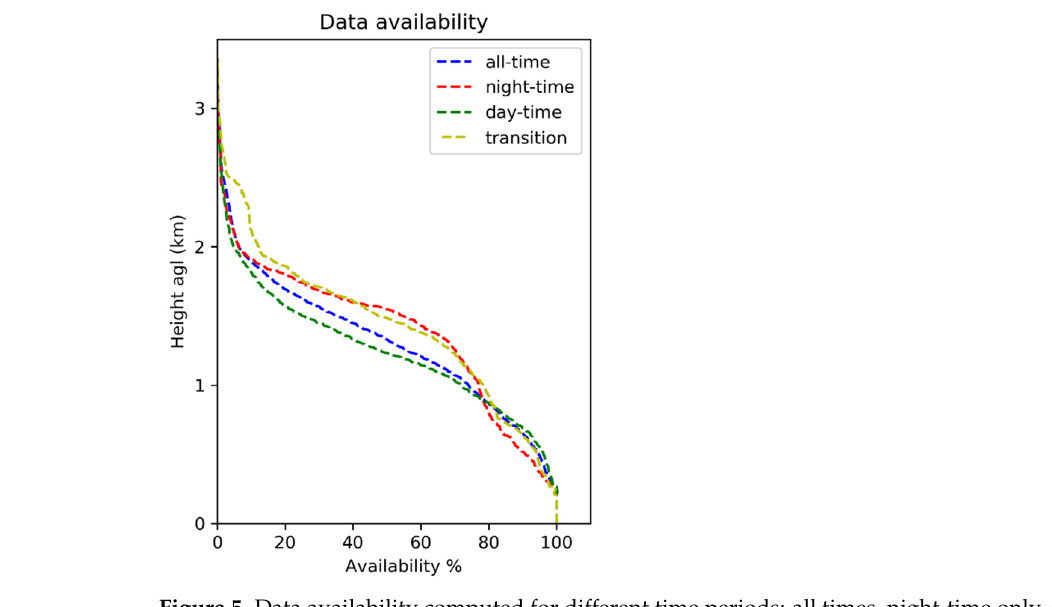
Figure 5. Data availability computed for different time periods: all times, night-time only, day-time only, and transition periods (±1 h around sunset and sunrise).